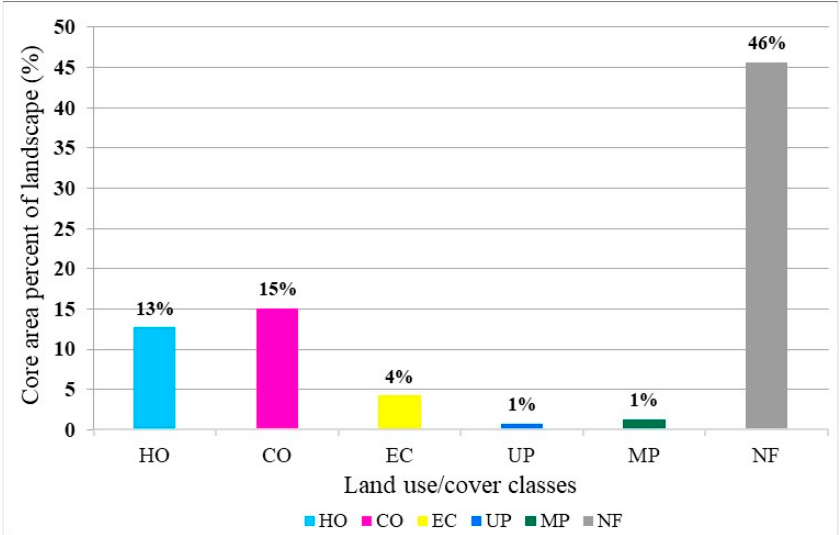
Figure 5. Core area percent of landscape (CPLAND).